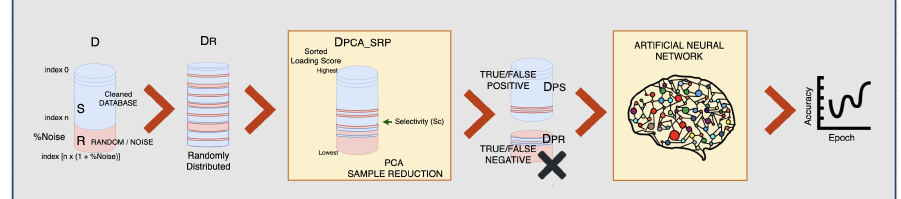
Figure 20. PCA–SRP to ANN